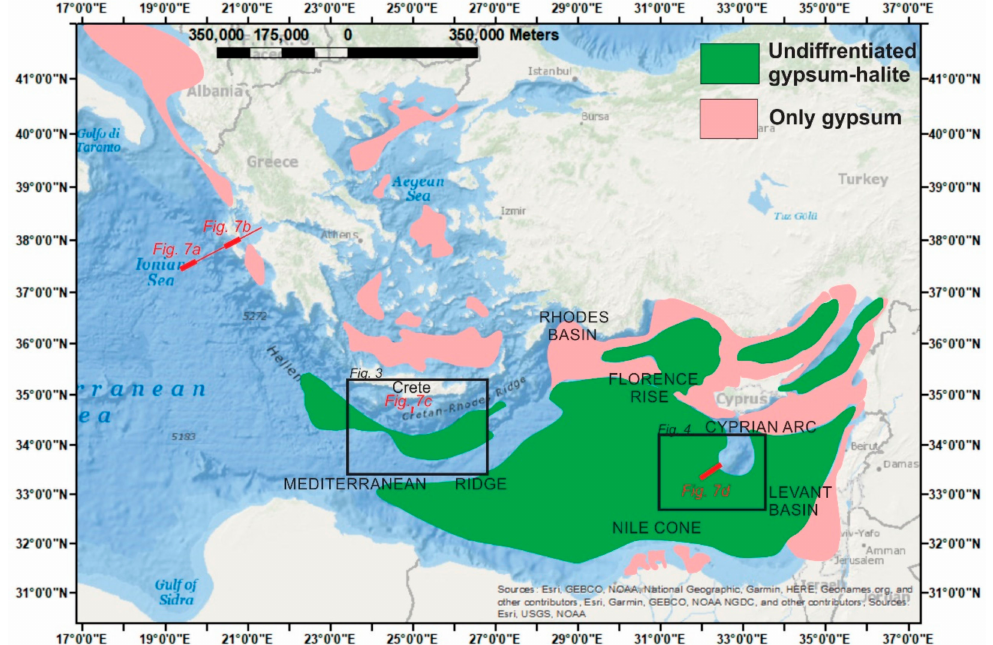
Figure 1. Map of the wide area of Eastern Mediterranean Sea and corresponding distribution of Late Miocene (Messinian) salt. The data concerning the base map are from the ArcGIS 10 online database. Black rectangles correspond to the automatic detection of bathymetric structures.The red lines in this figure show the locations of the seismic reflection profiles shown later in this work where the seafloor is deformed owing to the presence of underlying salt. Recently, updated maps concerning the distribution of both Triassic and Messinian salts in the Mediterranean Sea have been presented in previous works